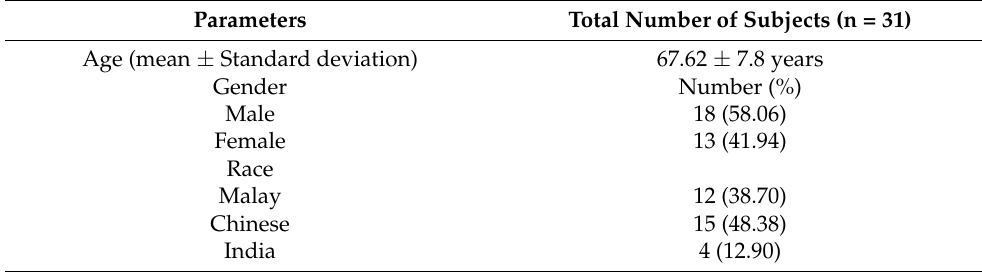
Table 1. Demographic details of the study subjects.